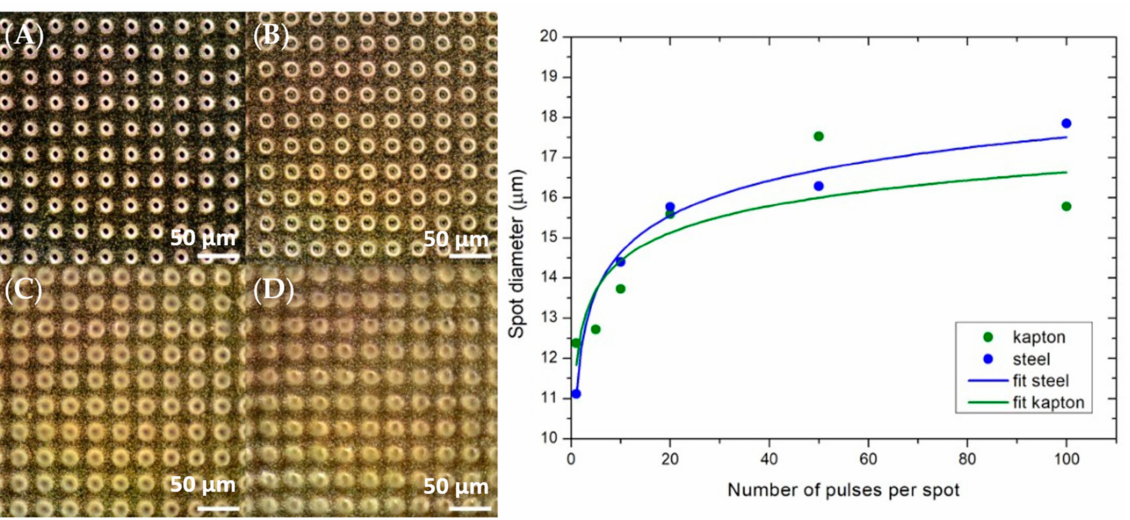
Figure 4. Panels ( A – D ) show arrays of craters from multipulse ablation experiments, for N = {10,20,50,100}. The crater edges become fuzzy on panels ( C ) and ( D ) due to high optical magnification and the focus position kept on the material’s surface. Scale bars are all equal to 50 µ m. The graph shows averaged data of spot diameter evolution with the number of pulses per spot ( N ) and added best function